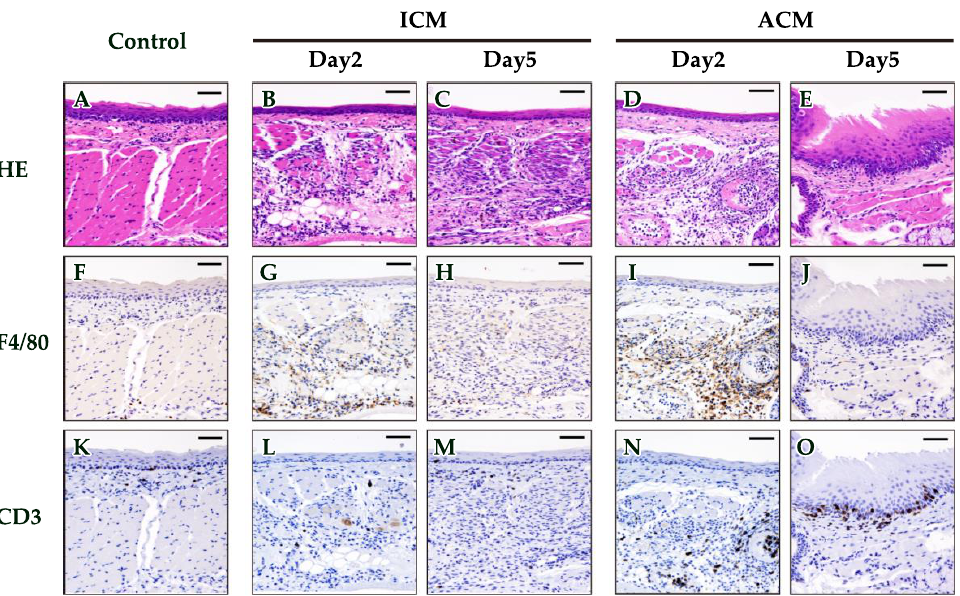
Figure 2. Histopathological and IHC analyses of F4/80 and CD3 in the OM of Pd–induced allergic mice. Representative photomicrographs of OM sections from control and Pd–induced ICM and ACM mice from days 2 and 5 after the challenge, stained with HE ( A – E ), F4/80 ( F – J ), and CD3 ( K – O ). Scale bar = 5 μm.